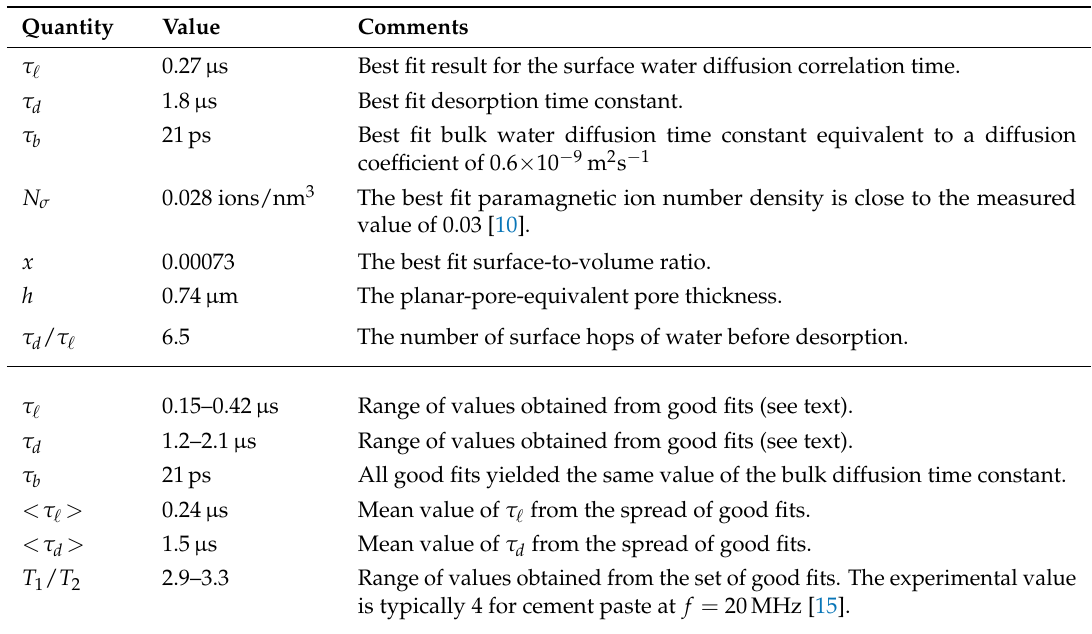
Table 2. Results of a fit of the 3 τ model to a FFC-NMR dispersion using 3TM for a hydrated mortar due to Barberon and co-workers